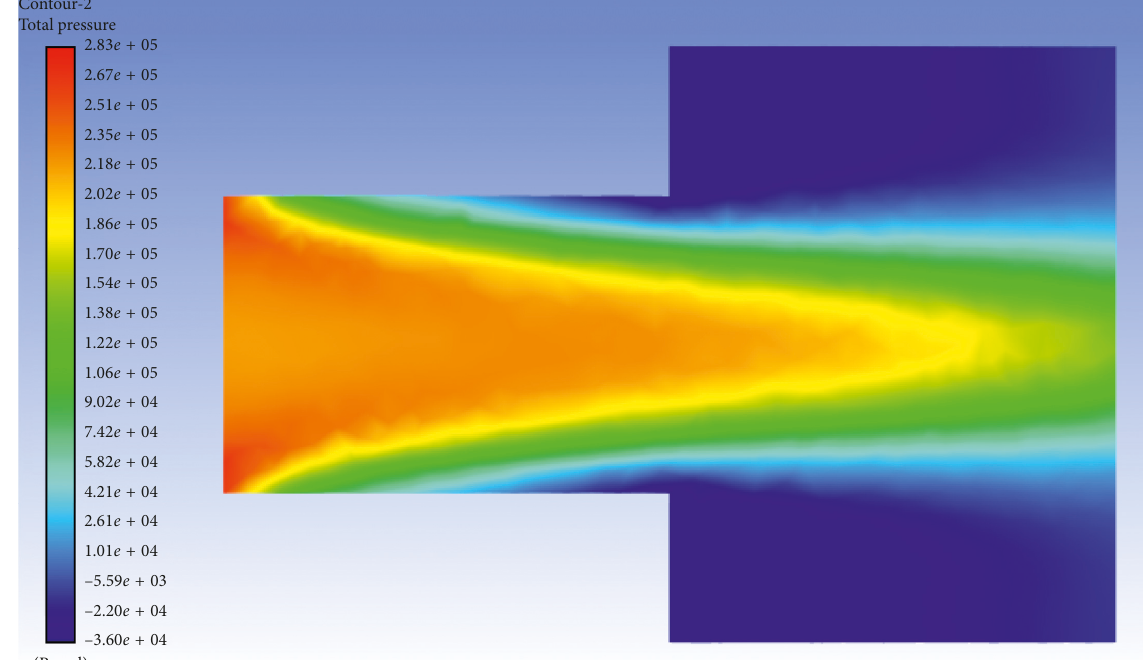
Figure 15: Pressure nephogram (sudden expansion ratio is 2).